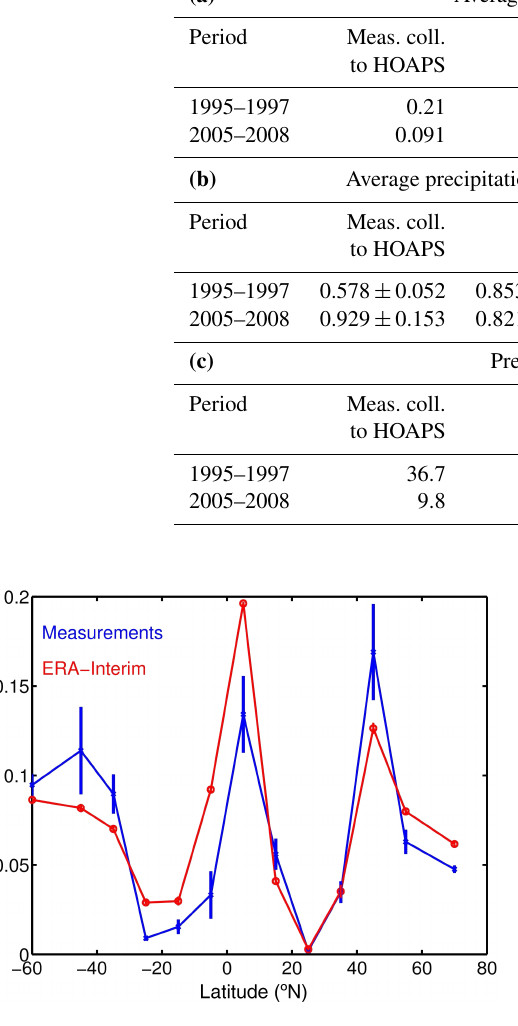
Figure 10. Mean precipitation rates of collocated data pairs for the period from 2005 to 2008 as a function of latitude (latitude belts are south of 50, 50–40, 40–30, 30–20, 20–10 and 10–0 ◦ S; 0–10, 10–20, 20–30, 30–40, 40–50, 50–60 and north of 60 ◦ N) for ERA-Interim compared to collocated measurements. Vertical bars indicate stan- dard deviation estimated by applying the bootstrap method (Efron, 1979). A lower threshold is not set for ERA-Interim